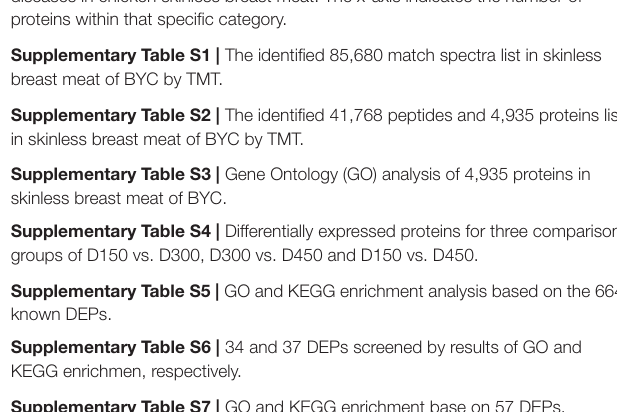
Supplementary Table S5 | GO and KEGG enrichment analysis based on the 664 known DEPs. Supplementary Table S6 | 34 and 37 DEPs screened by results of GO and KEGG enrichmen, respectively. Supplementary Table S7 | GO and KEGG enrichment base on 57